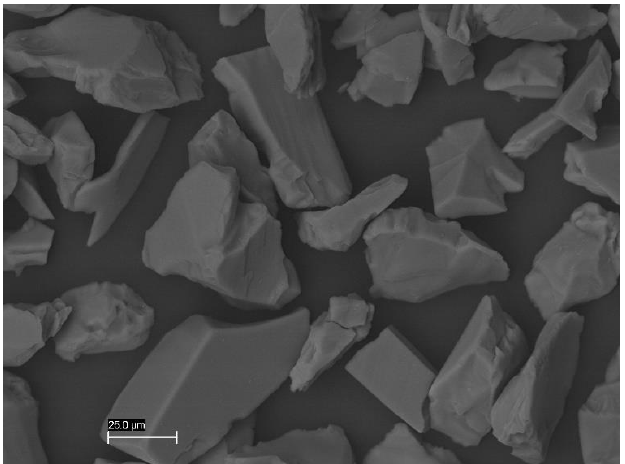
Figure 4. SEM image of Al₂O₃ particles of 50 µm that appeared in mean and with very irregular shapes. Mag. 1000×.